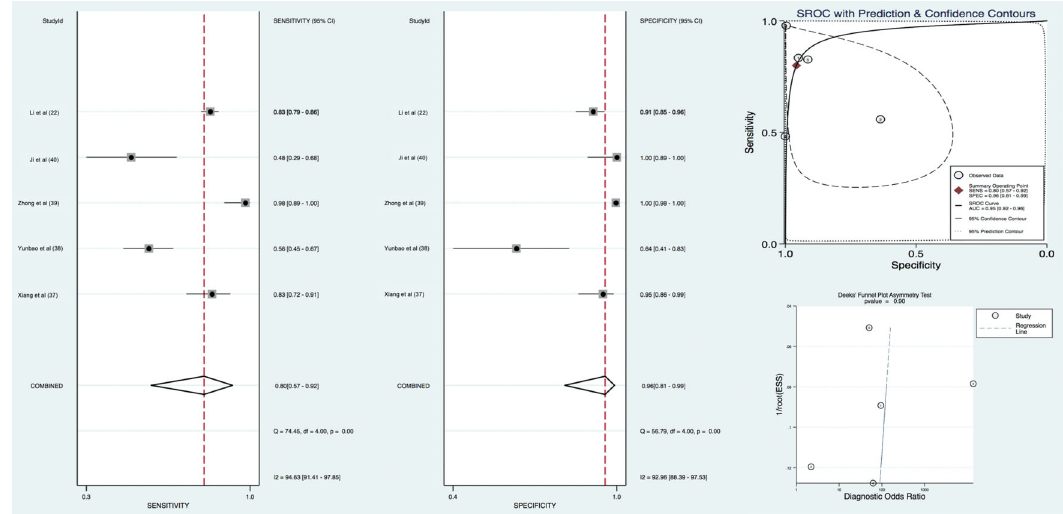
Figure 3 - IgM test pooled diagnostic value for diagnosis of SARS-CoV-2